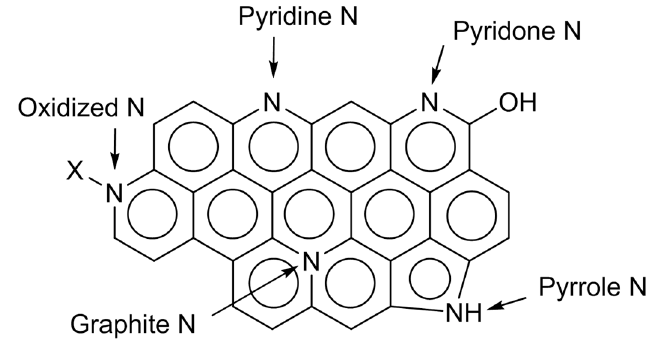
Figure 2. Possible structures of nitrogen species doped to carbon.